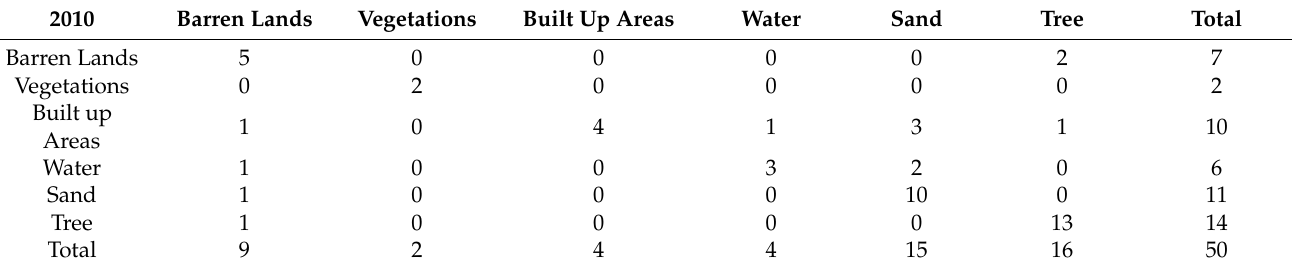
Table A2. Error Matrix of Landuse classification of